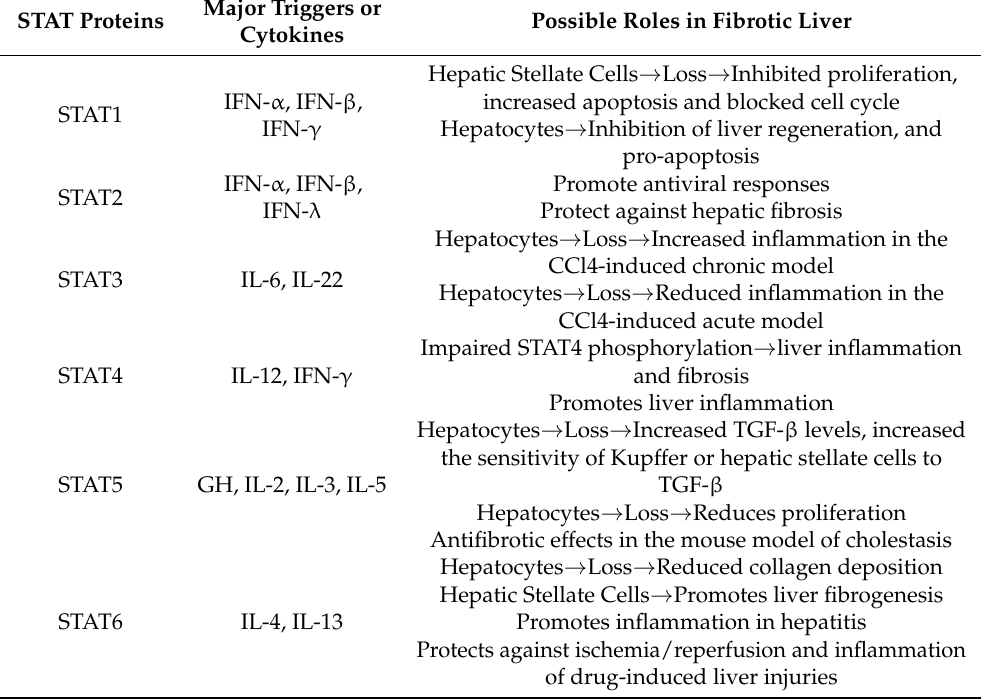
Table 1. The roles of STAT family in hepatic